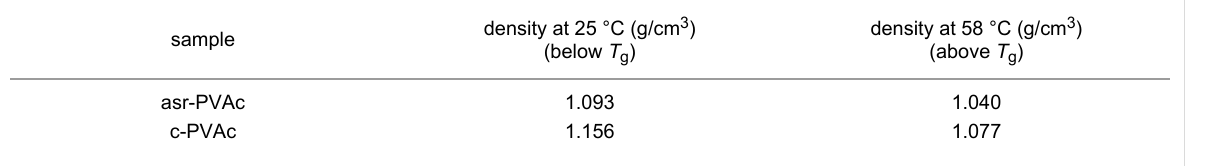
Table 1: Measured densities for as-received and coalesced PVAcs [71].